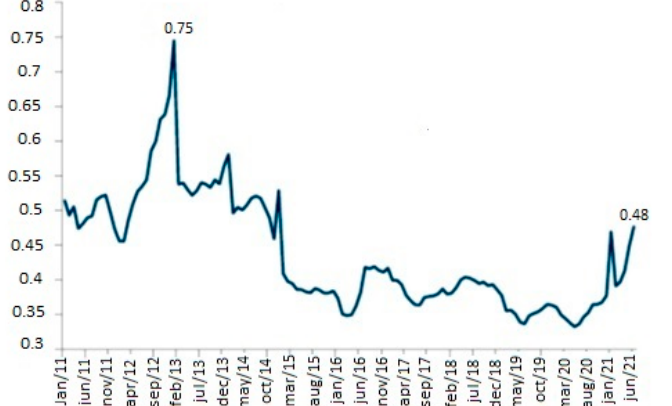
Figure 1. Brazilian soybean exports average prices (Jan 2011–Jun 2021) (In USD/kg). Adapted: [6]. The agribusiness trade balance ended in June 2021 with USD 10.8 billion in surplus.